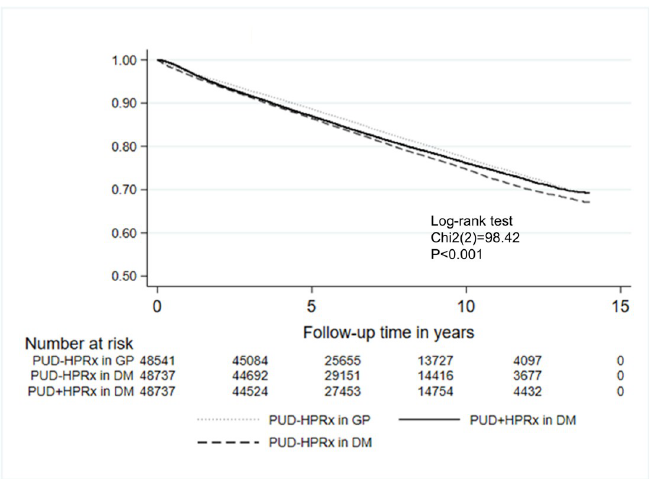
Fig 3. Cumulative survival rate. Lower cumulative survival rate in DM patients with peptic ulcer disease without Helicobacter pylori treatment (PUD-HPRx in DM) as compared with DM patients with peptic ulcer disease with Helicobacter pylori treatment (PUD+HPRx in DM) and with the general population with peptic ulcer disease without Helicobacter pylori treatment (PUD-HPRx in general population). Kaplan-Meier curves estimated the probability of survival rate.